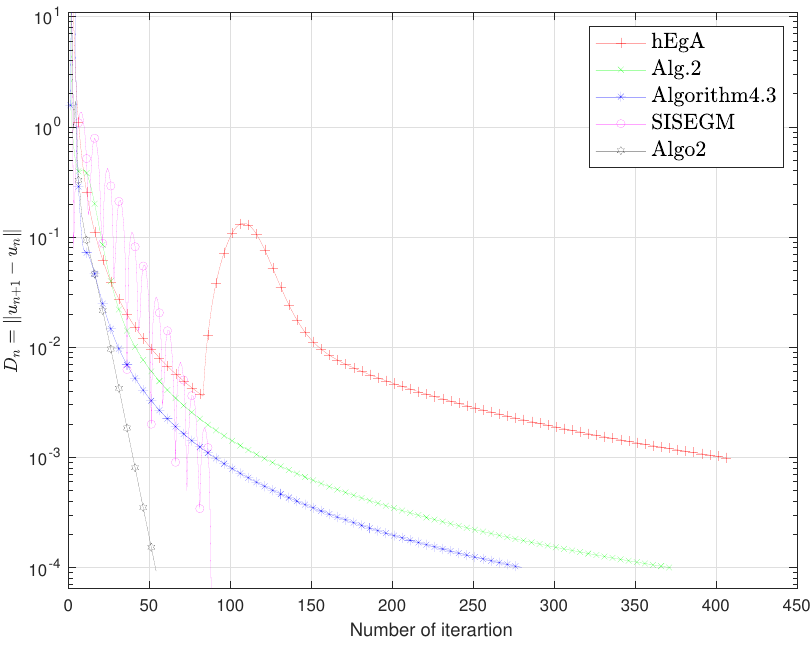
Figure 16. Example 3: Elapsed time 2.28, 2.40, 1.35, 0.58, 0.37